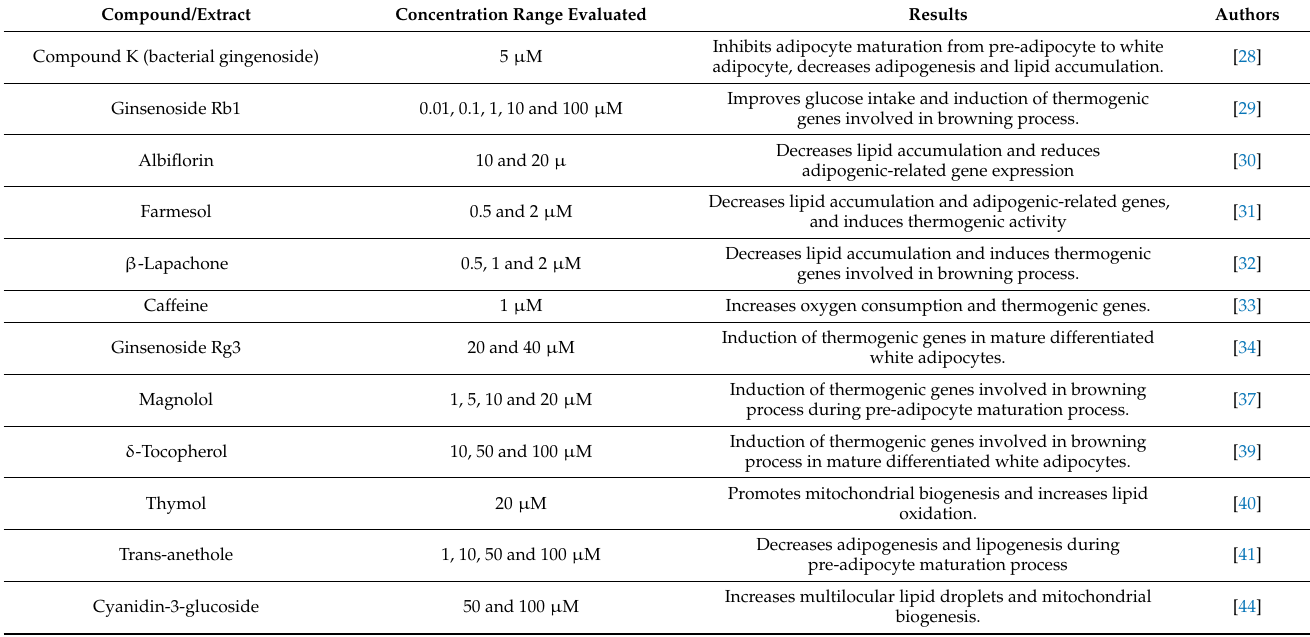
Table 2. In-vitro effects of several bioactive compounds on the browning